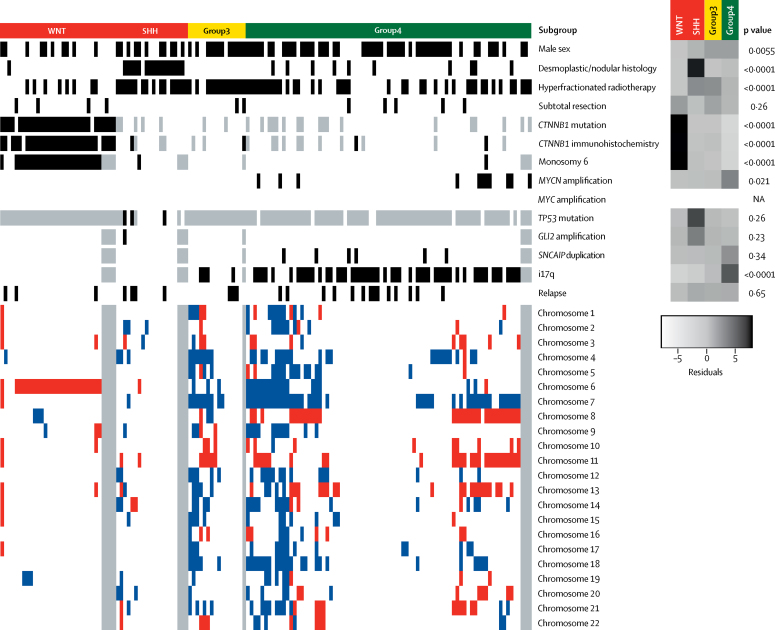
Clinical and disease-associated molecular features of the HIT-SIOP PNET 4 cohortAll 147 patient samples available from the HIT-SIOP PNET 4 cohort with subgroup information are shown, including 11 samples without data on chromosomal aberrations. Black indicates positivity for an assessed feature (for sex, black indicates male and white indicates female). Grey indicates missing data. Red indicates chromosomal losses and blue indicates chromosomal gains. NA=not assessed. Residual scores from χ2 tests of association are shown (darker shades of grey indicate stronger enrichment) alongside p values from Fisher's exact tests.